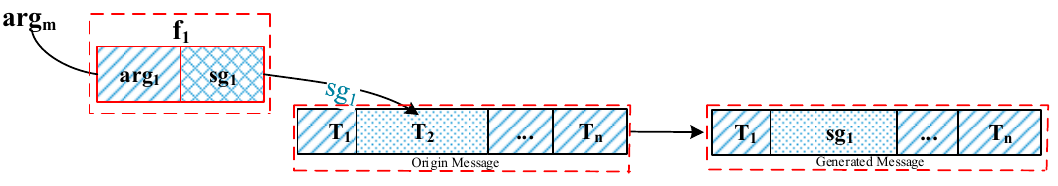
Figure 8. Message construction in the first category.